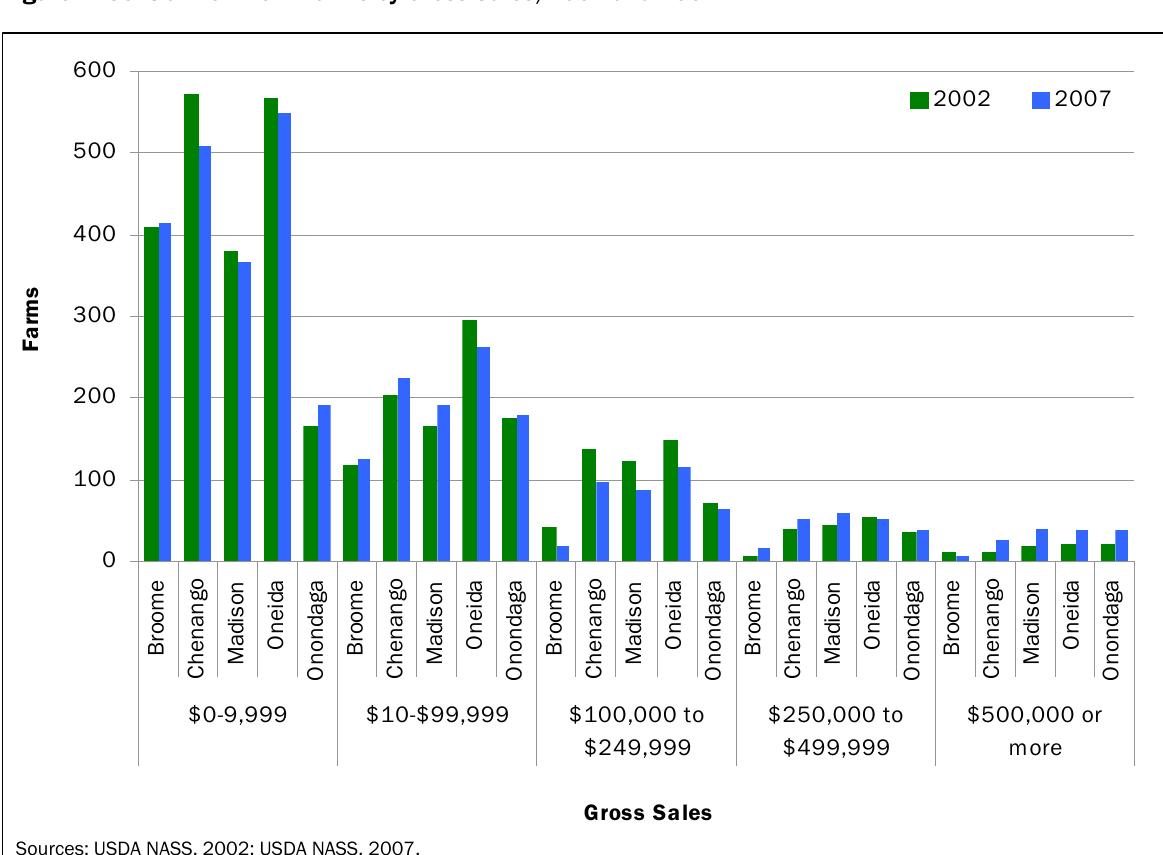
Figure 1. Central New York Farms by Gross Sales, 2002 and